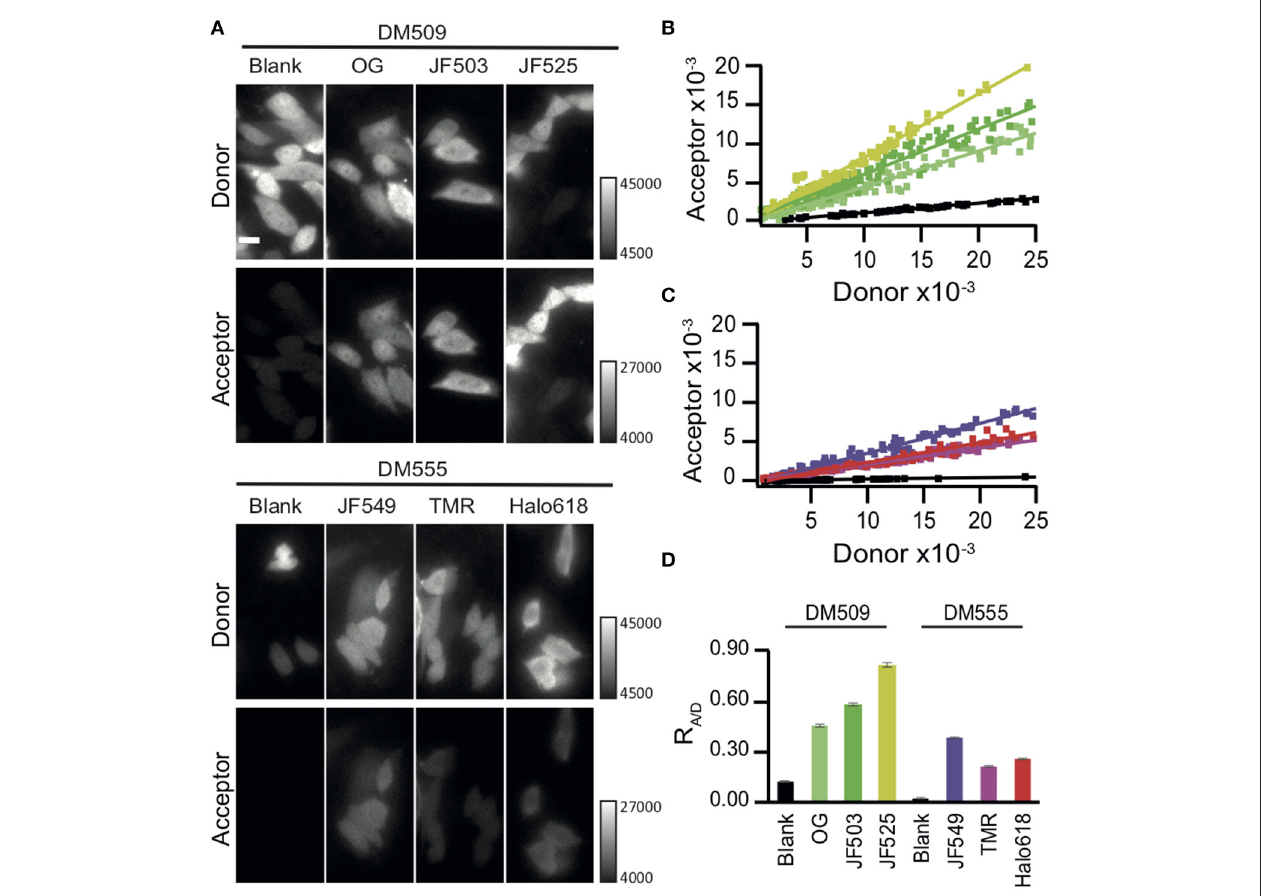
FIGURE 2 | BRET imaging in living cells. (A) Images of CHO-K1 cells expressing Halo-NanoLuc. Images were acquired after loading of respective ligands (OG, JF503, JF525, JM549, TMR, and Halo618) or in the absence of ligands (blank), using a dichroic mirror indicated to separate donor (upper) and acceptor (lower) windows. All images were obtained with identical acquisition settings (APON 60XOTIRF, NA = 1.49, exposure time = 0.75s). Scale bar = 10 µ m. (B,C) Linear regression analyses of the acceptor vs. donor signal intensities for green-shifted (B) or orange-red ligands (C) . The color codes of ligand-loaded cells are same as in Figure 1 . Cells in the absence of ligands (blank) are shown in black. (D) Mean R A / D ± SEM calculated from the cells labeled with different ligands. n ≥